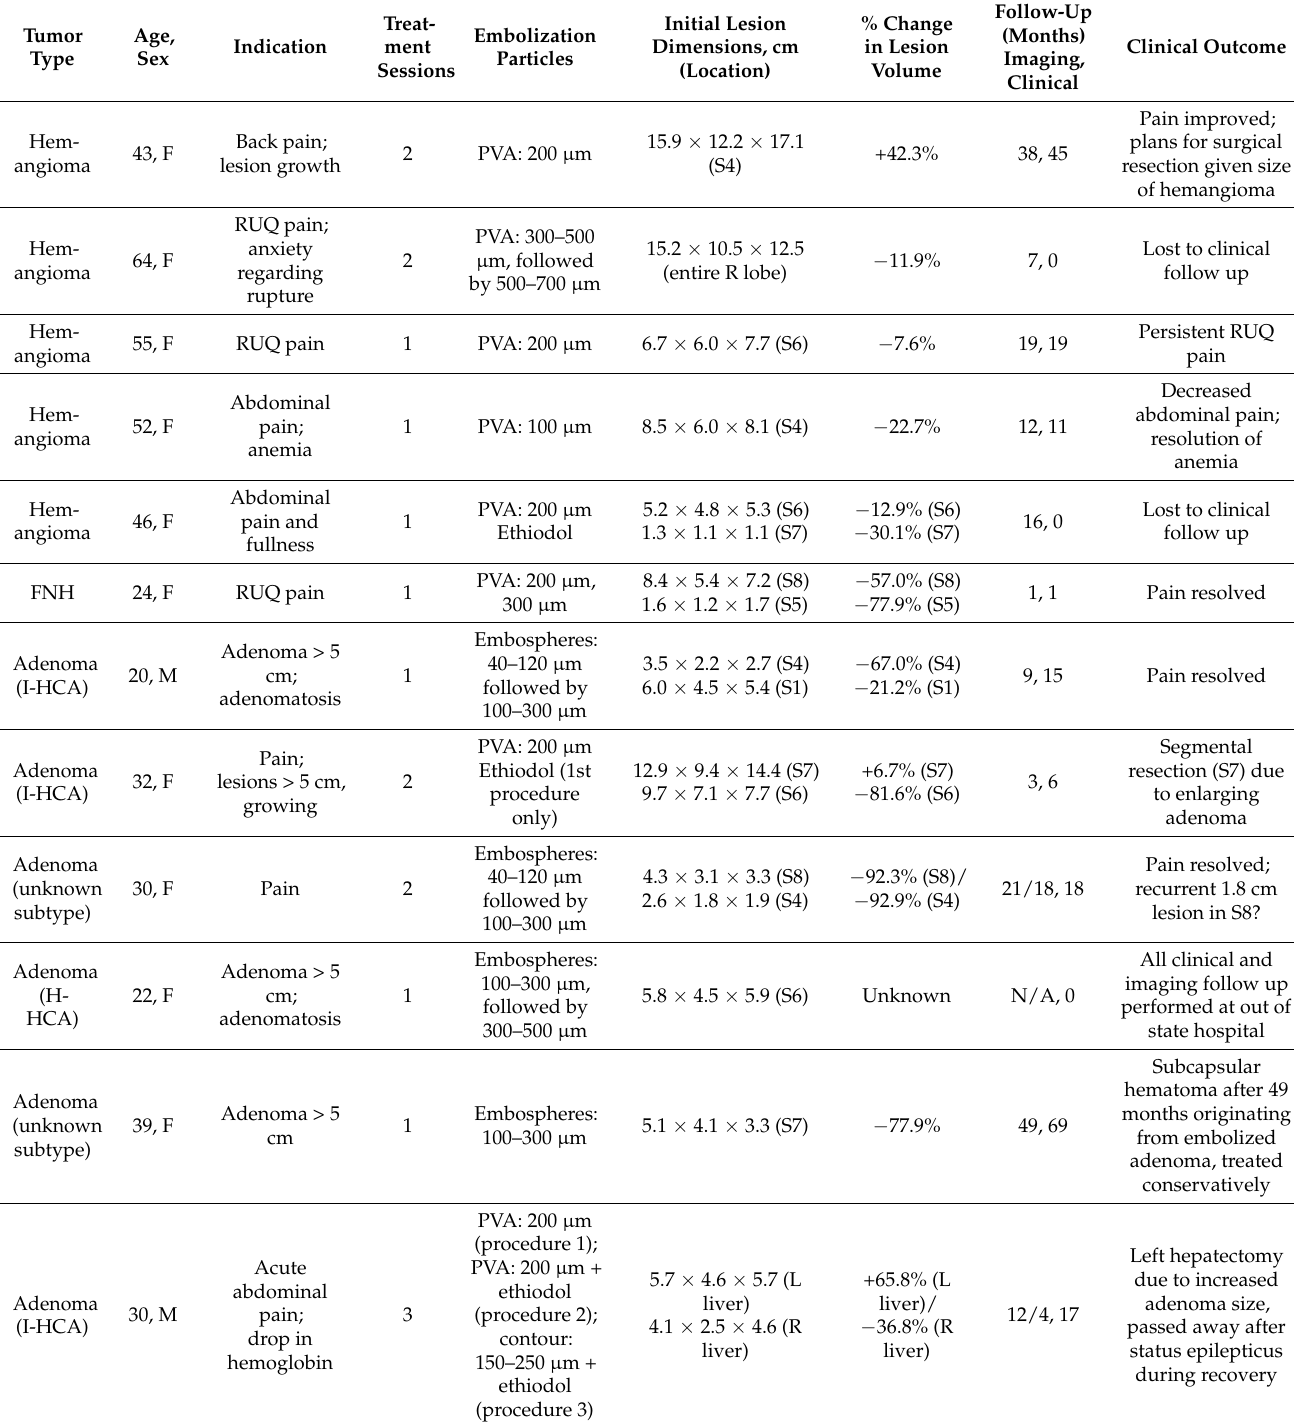
Table 1. Demographic data, indications for transarterial embolization, procedural details, lesion size and change in volume, and outcomes for bland transarterial embolization of hepatic hemangiomas, focal nodular hyperplasia (FNH), and hepatic adenomas. “S” refers to liver segment when applicable. The adenoma tumor subtype is listed in parentheses for lesions with known pathology. I-HCA = inflammatory subtype, H-HCA = HNF-1 α subtype, PVA: polyvinyl alcohol, RUQ: right upper